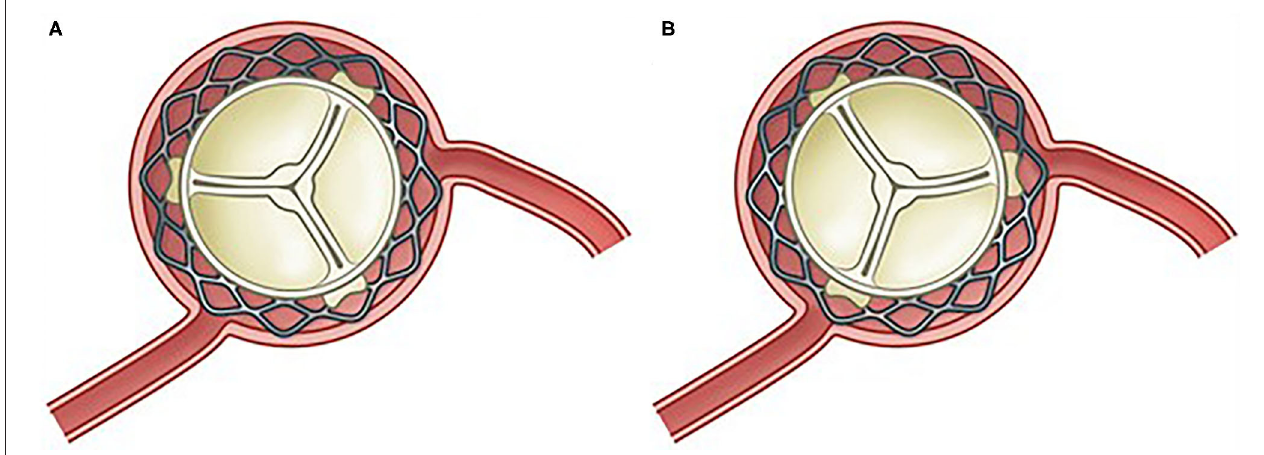
FIGURE 2 | Commissural alignment between native and TAVI valve makes for easy coronary access (A) compared with commissural misalignment (B)